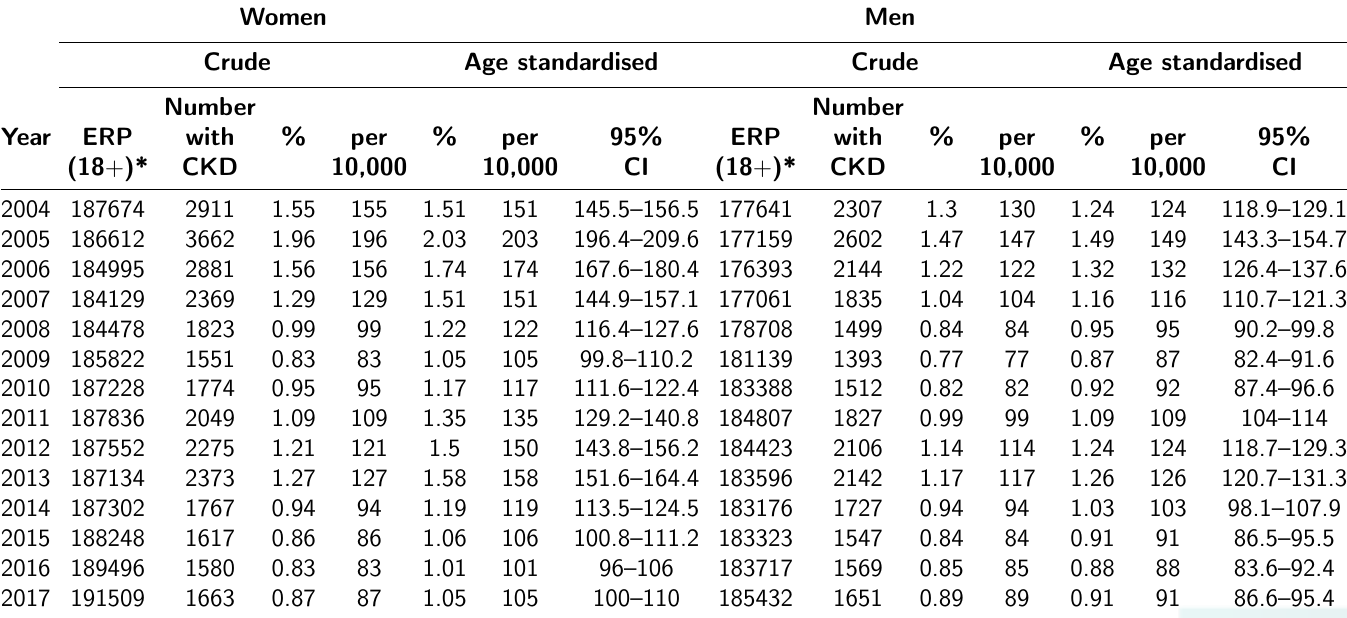
Supplementary table 2: Incidence of chronic kidney disease in Tasmania by